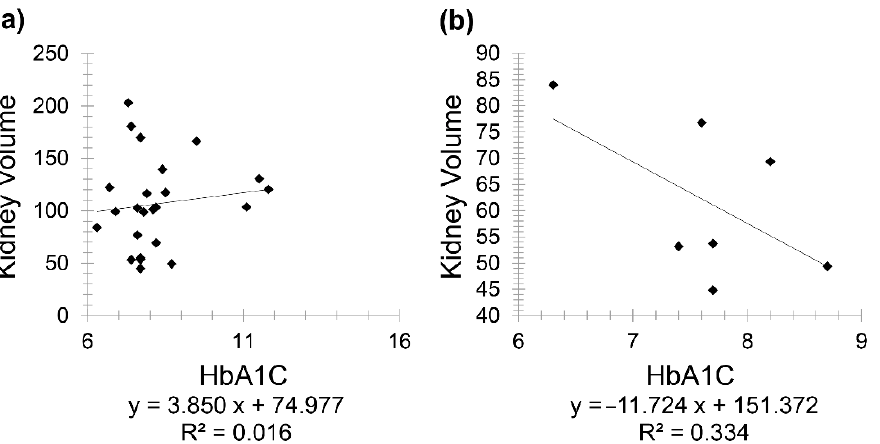
Figure 6. Scatter plot graphs showing ( a ) positive correlation between kidney volume and HbA1C in controlled diabetic patients ( r = 0.126) and ( b ) stronger negative correlation ( r = − 0.577) between the same variables in controlled diabetic patients for 20 years and above.